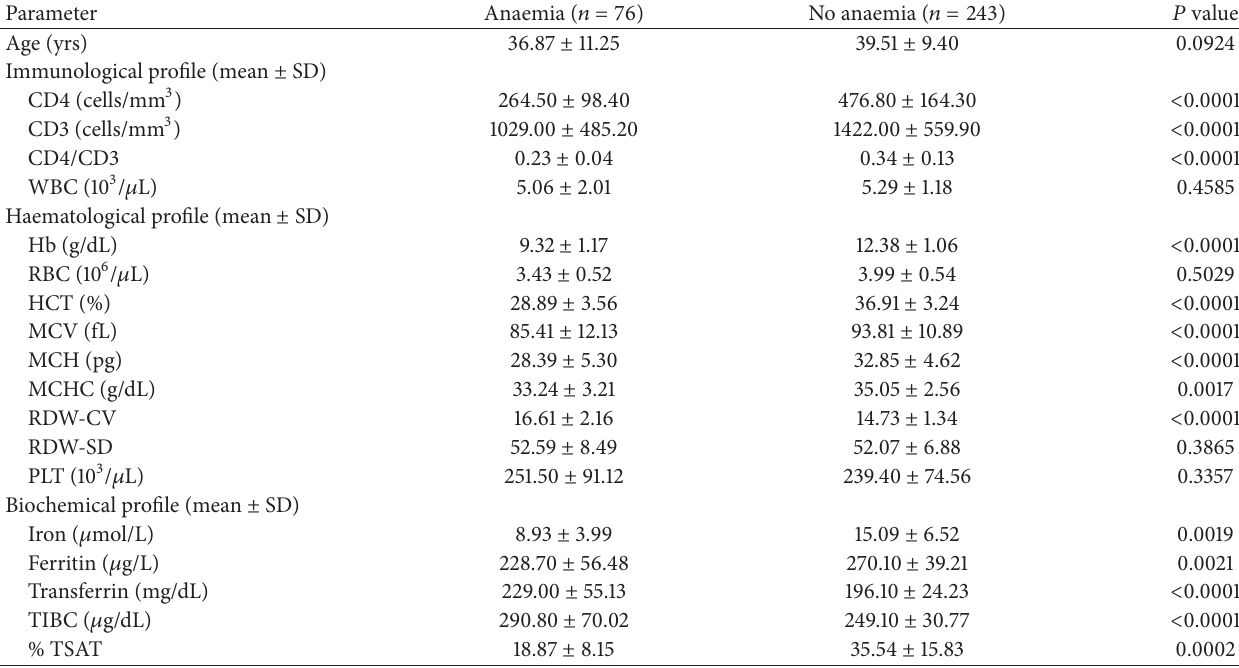
Table 3: Immunological, haematological, and biochemical profiles of the study population stratified by anaemia status. Parameter